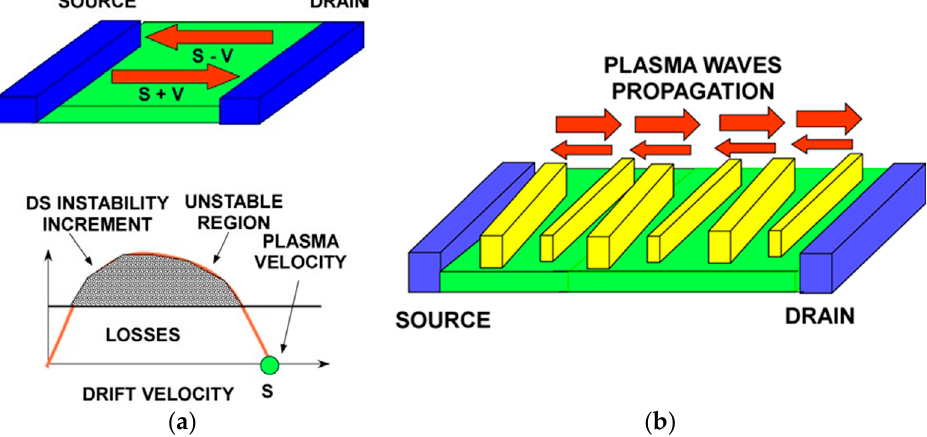
Figure 5. The Dyakonov–Shur (DS) instability increment ( a ) and 1D plasmonic crystal implementation ( b ).